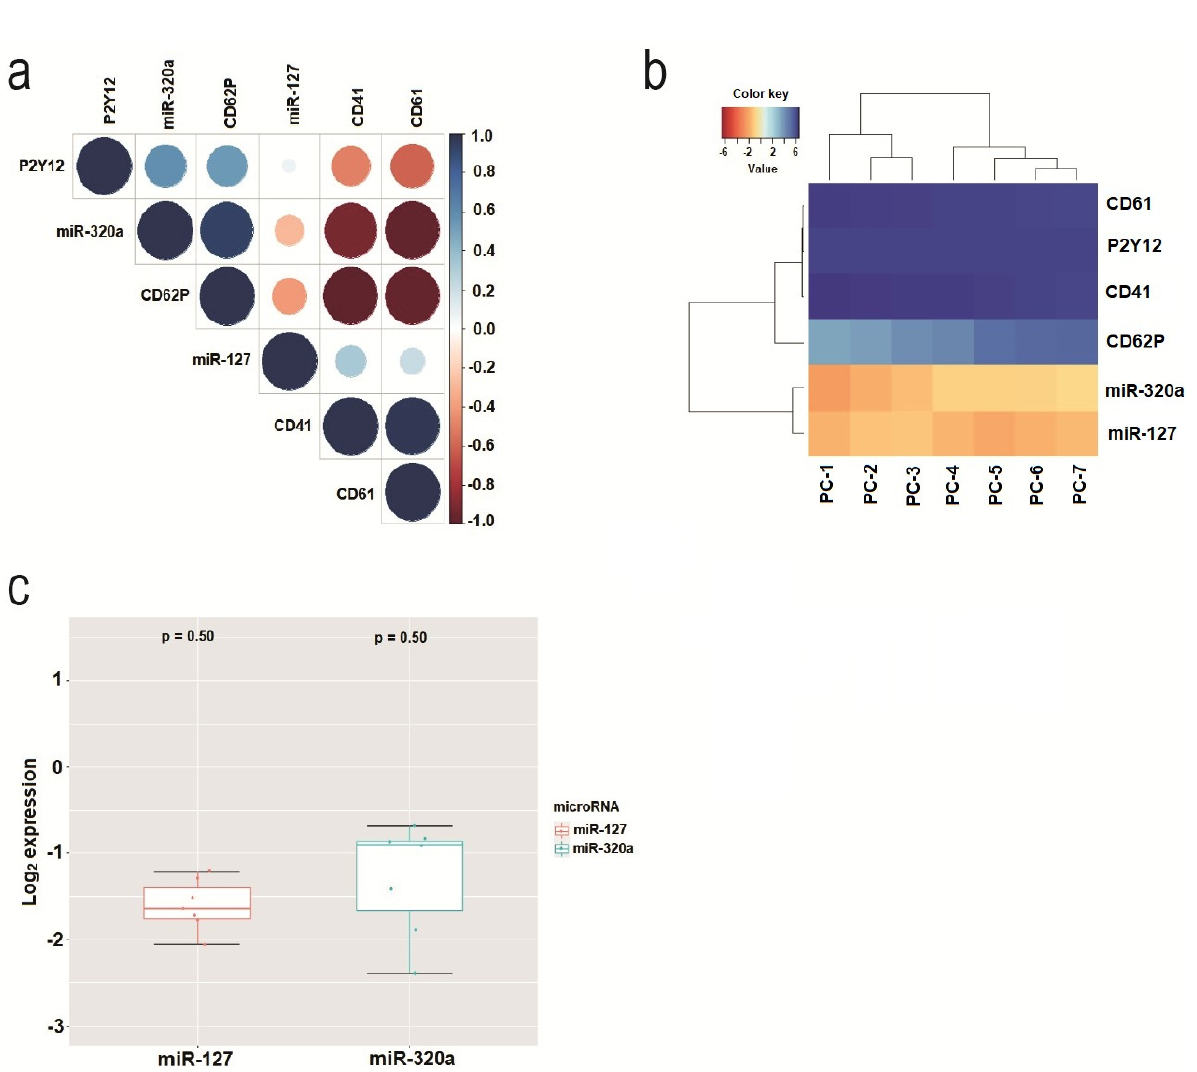
Figure 3. ( a ) Correlogram showing the miRNAs and membrane receptors that most correlated during the 7 days of PC storage. The scales with a blue gradient are positively correlated, while those with a red gradient are negatively correlated; the white gradient represents insignificant correlation ( p > 0.01). ( b ) Heatmap showing the patterns of expression of miRNAs and receptors during the 7 days of storage of PCs. Z-score was the metric applied to infer the best clustering patterns. Gradients with a tendency towards a red color indicate a lower Z-score, and gradients with a tendency towards a blue color indicate a greater Z-score. ( c ) Variation in the levels of expression of miR-127 and miR-320a during the 7 days of storage.